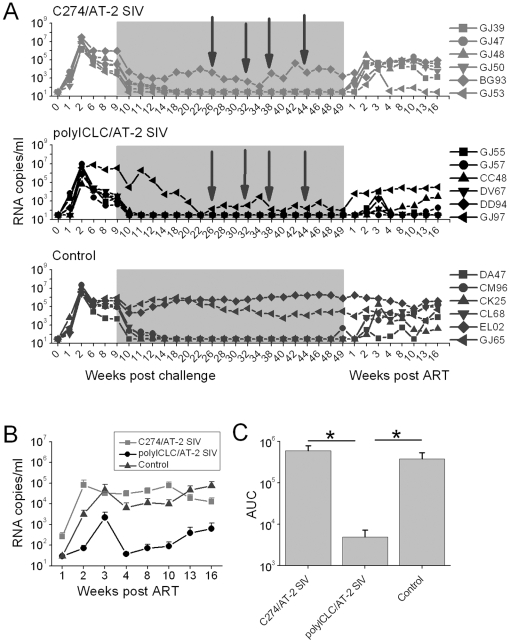
Viral loads of polyICLC-treated animals are significantly lower, after cessation of ART.(A) Plasma SIV RNA copies/ml were determined by PCR. Each symbol indicates an individual animal. The ART treatment period is indicated by the shaded grey box. Arrows indicate immunization time-point. (B) Average (geometric means) viral loads (±SEM) are shown for the ART-responding animals (5 in the C274/AT-2 SIV group, 5 in the polyICLC/AT-2 SIV group and 4 in the control group). Asterisks indicate significant differences between: polyICLC vs both C274 and controls at weeks 2, 4, 8 and 16, p<0.03; polyICLC vs C274 at weeks 3 and 10, p<0.02; polyICLC vs control at week 13, p<0.03. (C) Average Area Under the Curve (AUC) is shown for the ART-responding animals in each group (±SEM). p<0.03 for polyICLC vs C274 and p<0.02 for polyICLC vs control.